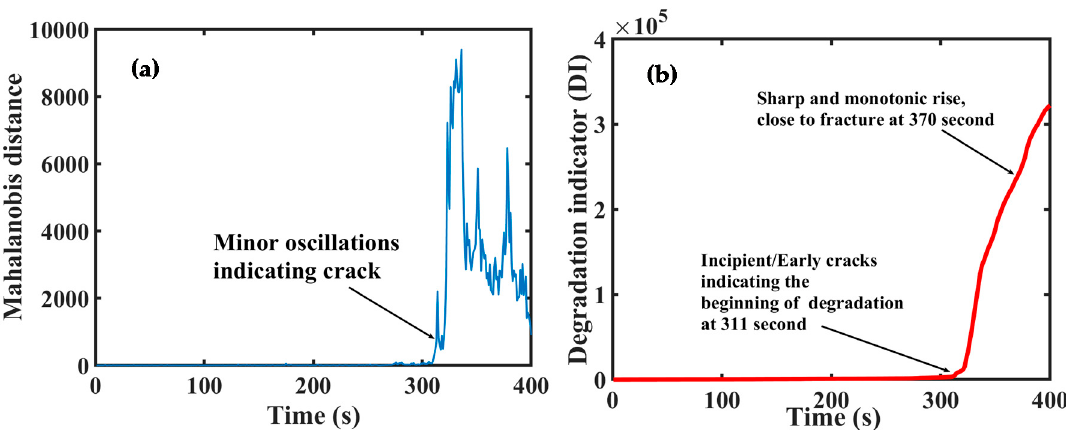
Figure 9. Time-history of Mahalanobis distance (MD) and DI over the entire lifetime of concrete beam: ( a ) fusing all the selected features in MD and ( b ) DI using MD and noise-removal (NR) approach.